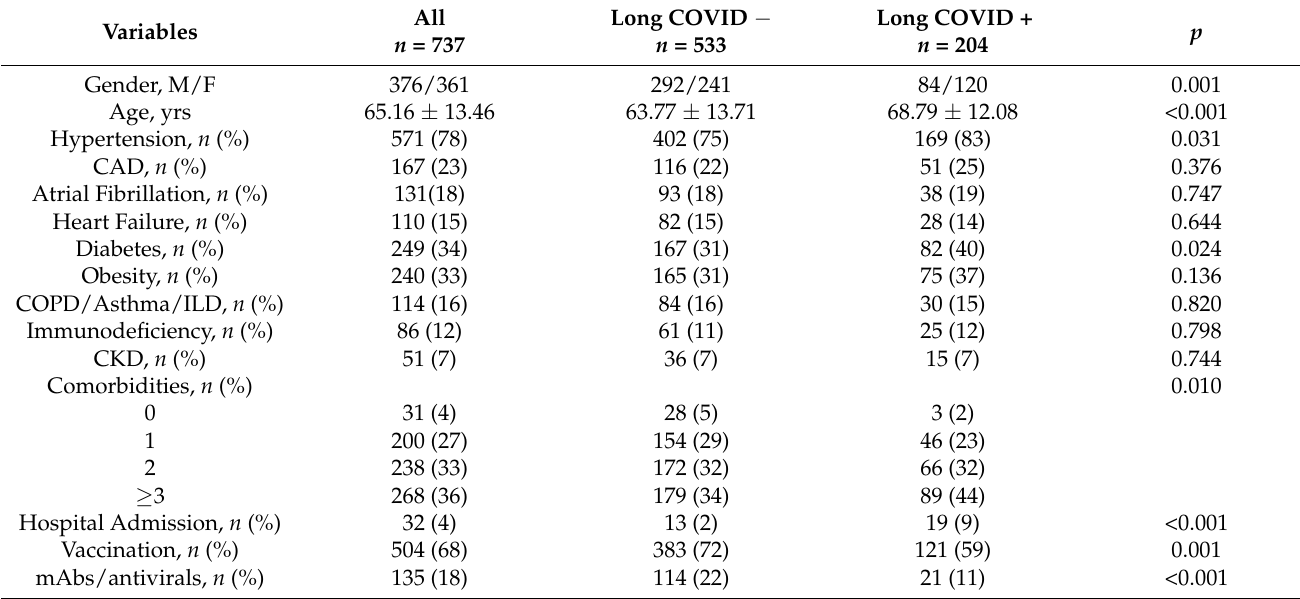
Table 1. Demographic and clinical characteristics of the study